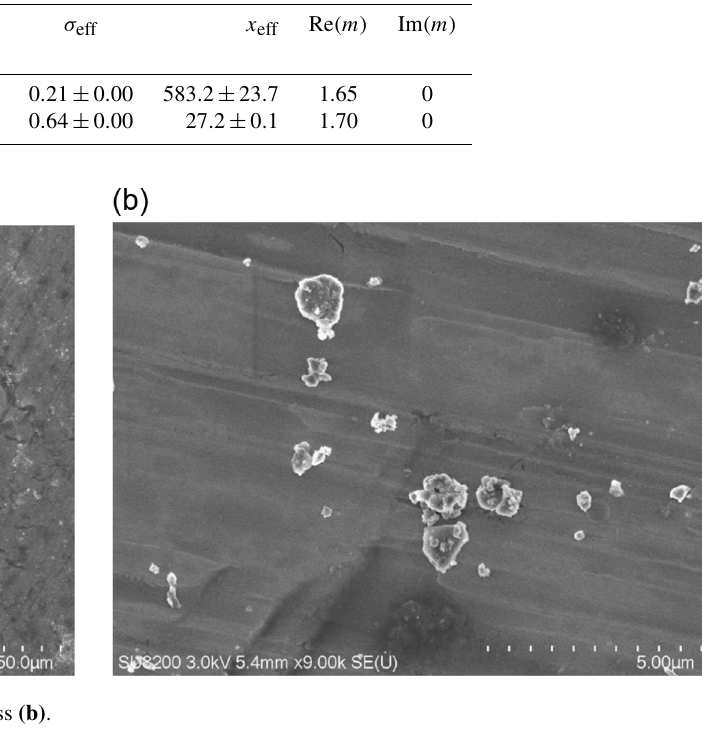
Figure 2. SEM images for pristine loess (a) and milled loess (b)